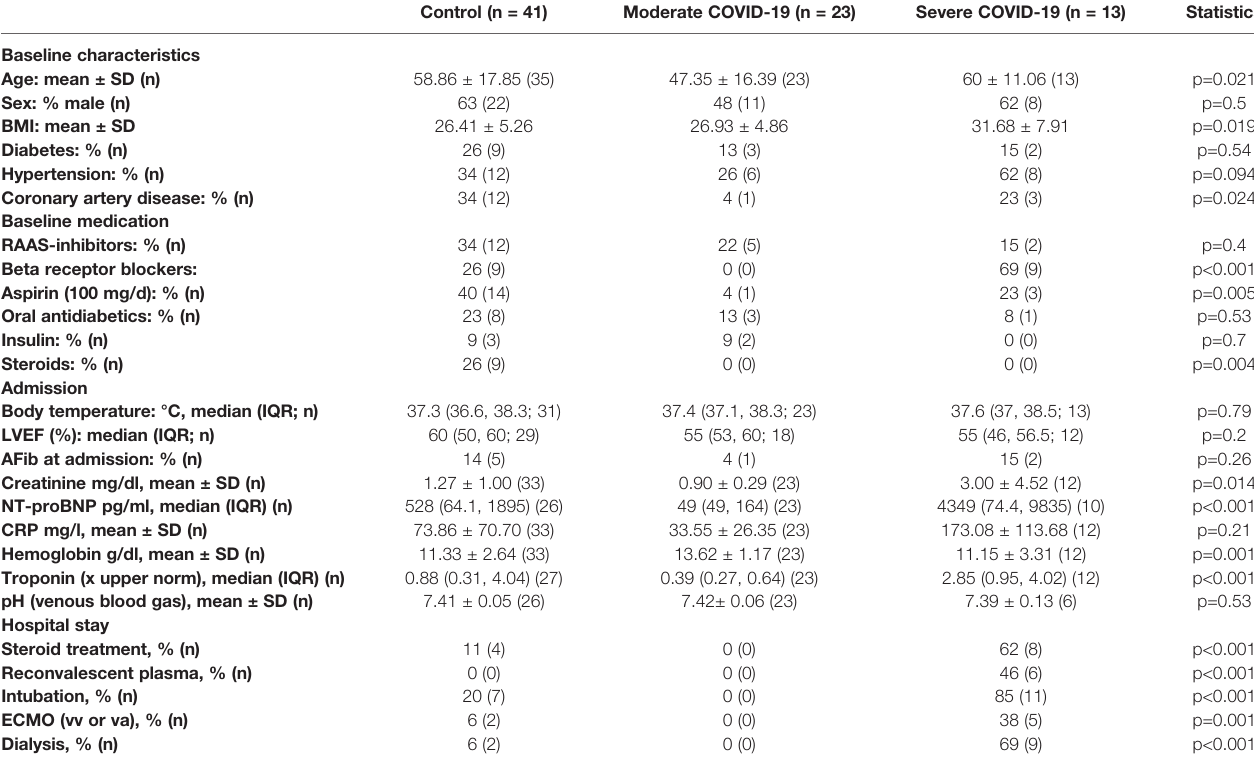
TABLE 1 | Patient characteristics (all